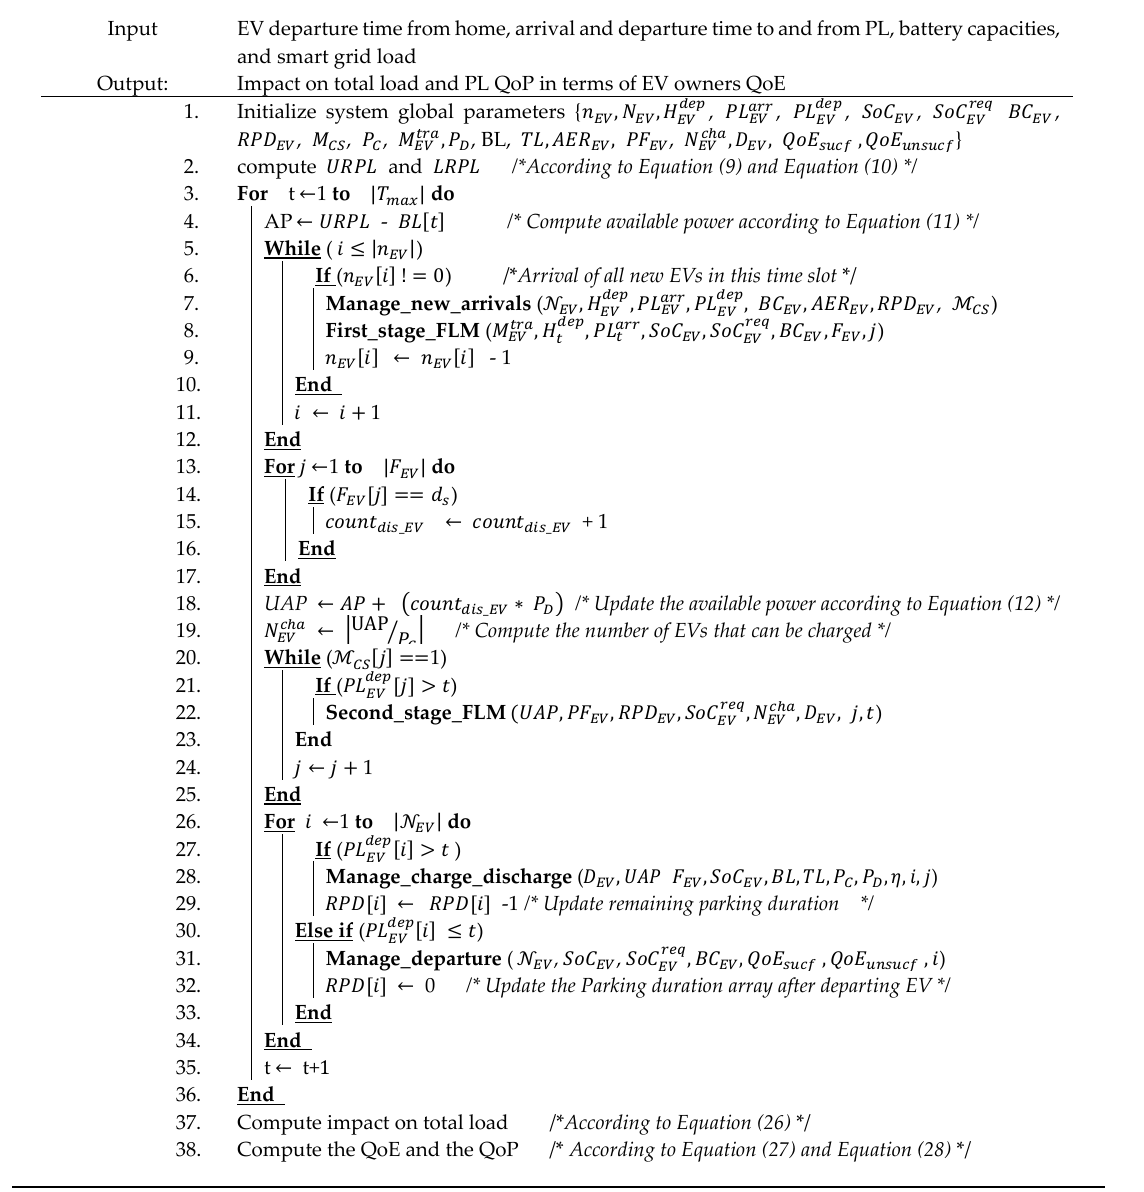
Algorithm 1: Two-Stage Fuzzy Logic Inference Main Algorithm